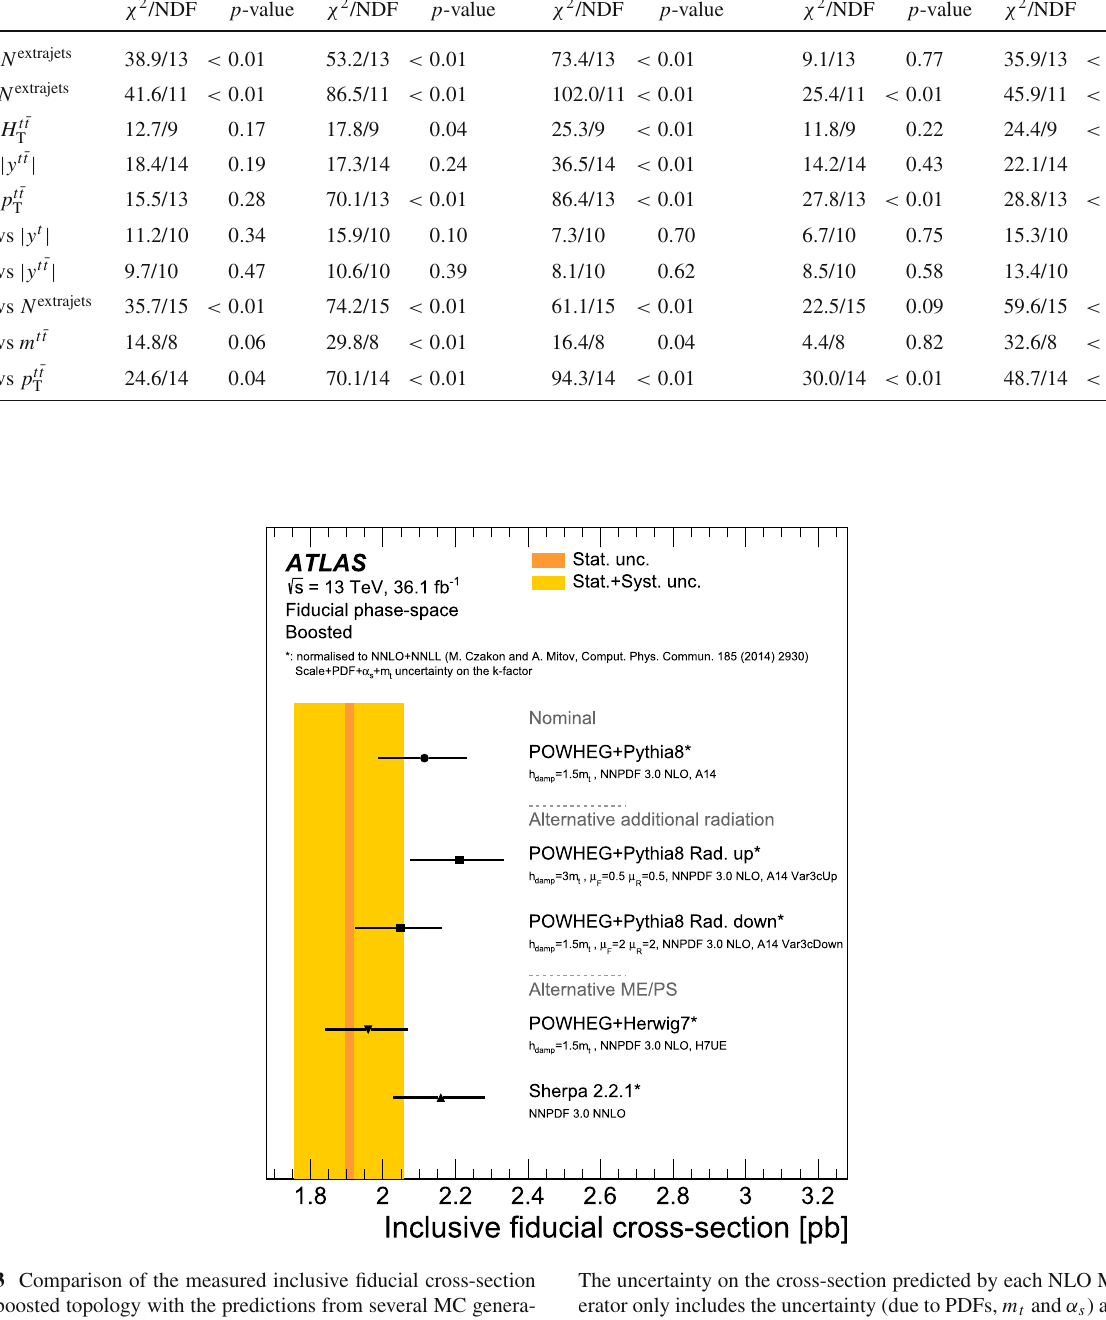
calculated using the covariance matrix of the measured spectrum. The NDF is equal to the number of bins in the distribution